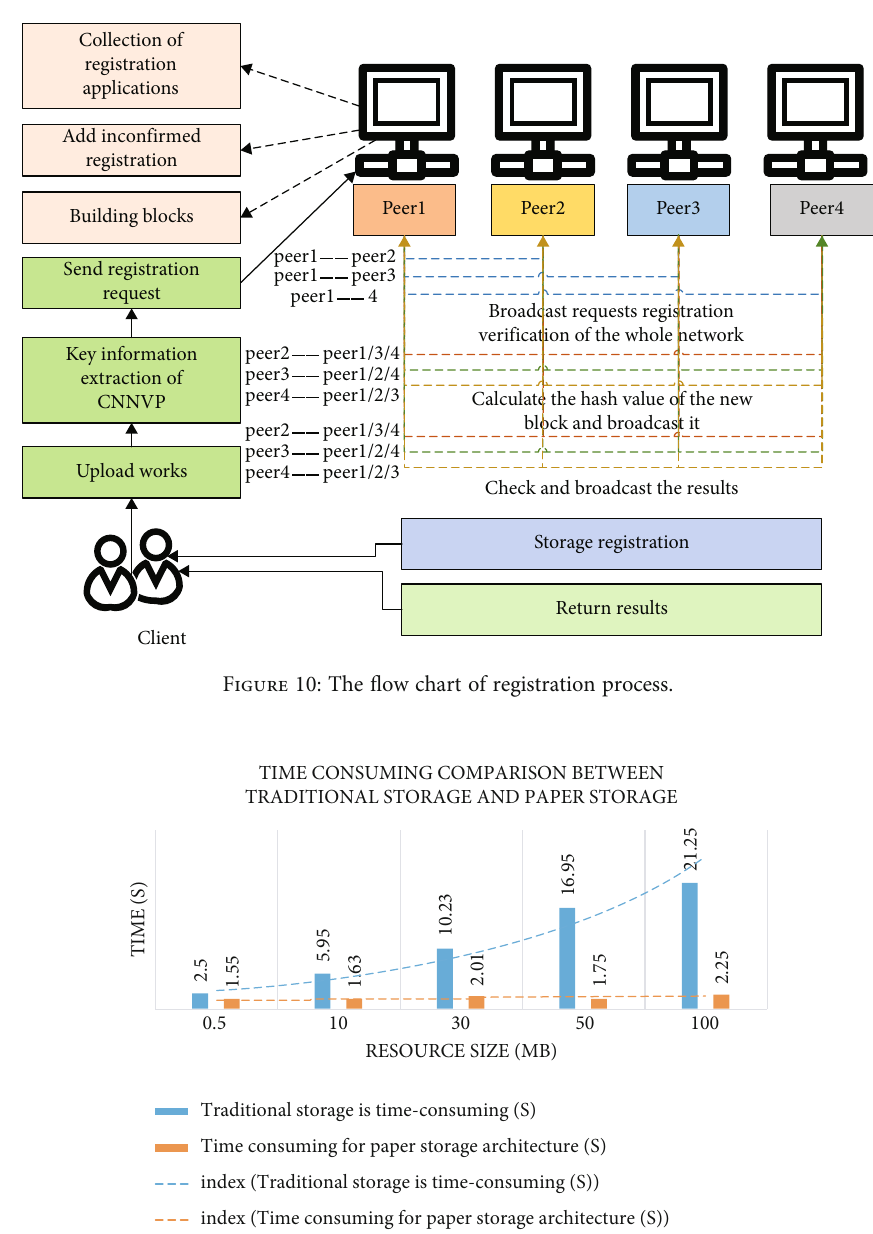
Figure 11: Time-consuming comparison between the traditional storage mode and the paper storage mode.